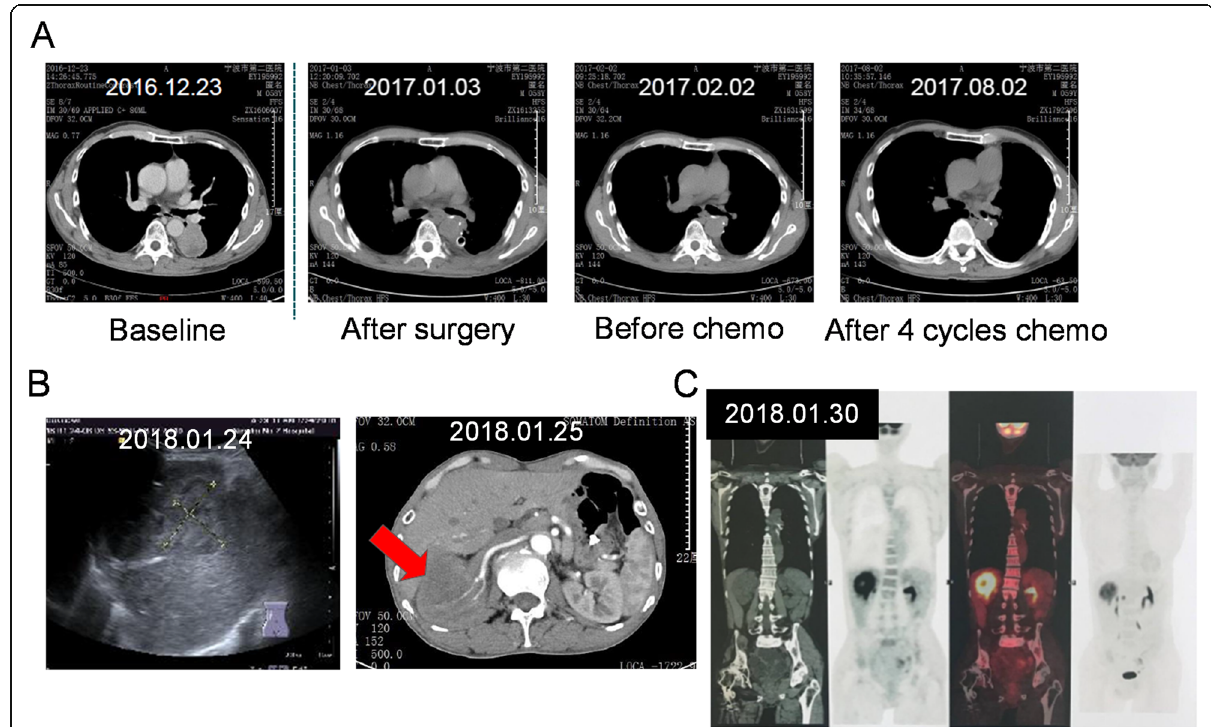
Fig. 1 a Thoracic CT scan illustrating the tumor on the left lower lung and successful treatment with lobectomy and 4 cycles of platinum-based chemotherapy. b Ultrasonography and CT urography scans illustrating the detection of kidney tumor on January 2018. c PET/CT scans illustrating the increased FDG metabolism on the right kidney and colon, and the absence of disease recurrence or relapse in the